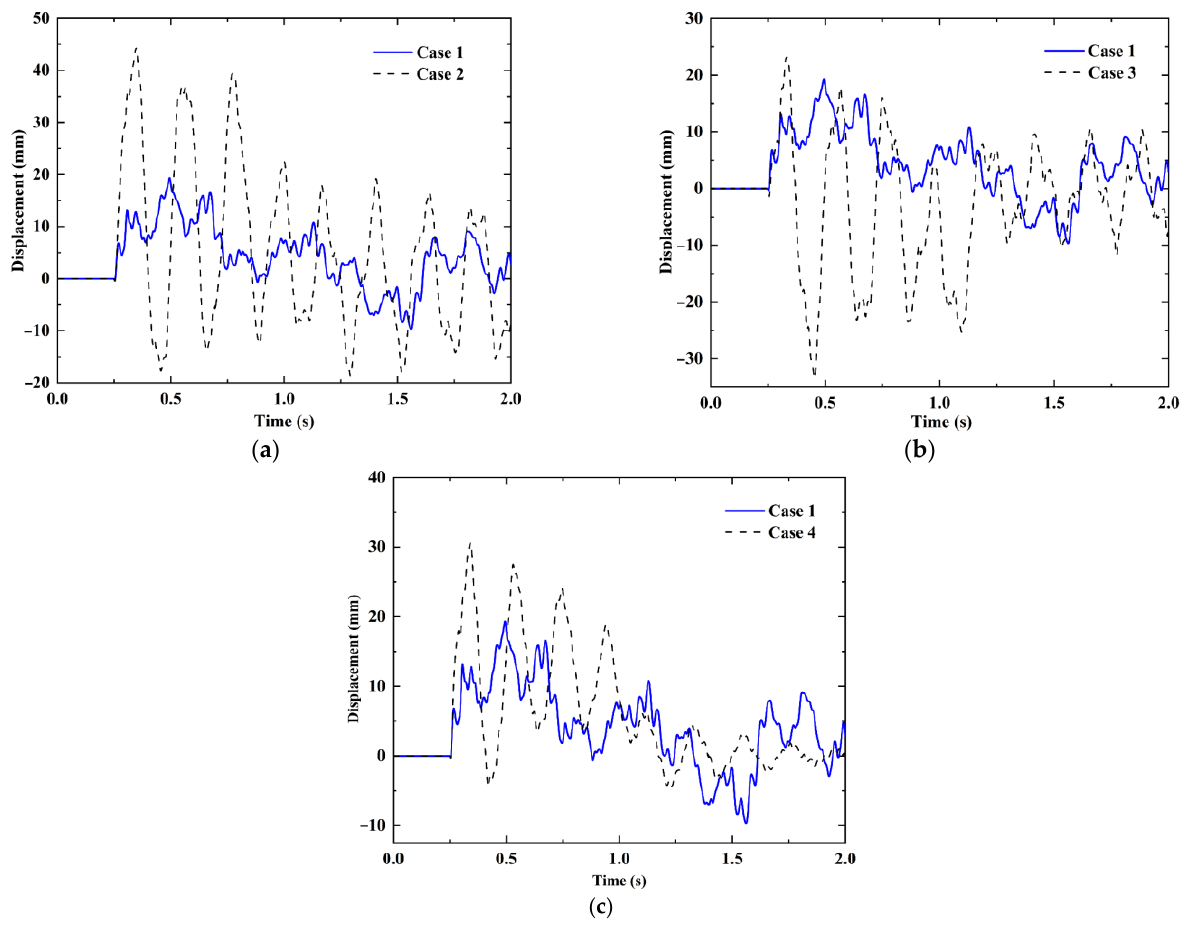
Figure 26. Comparison of pier-top displacement under different working conditions: ( a ) case 1 and case 2; ( b ) case 1 and case 3; ( c ) case 1 and case 4.